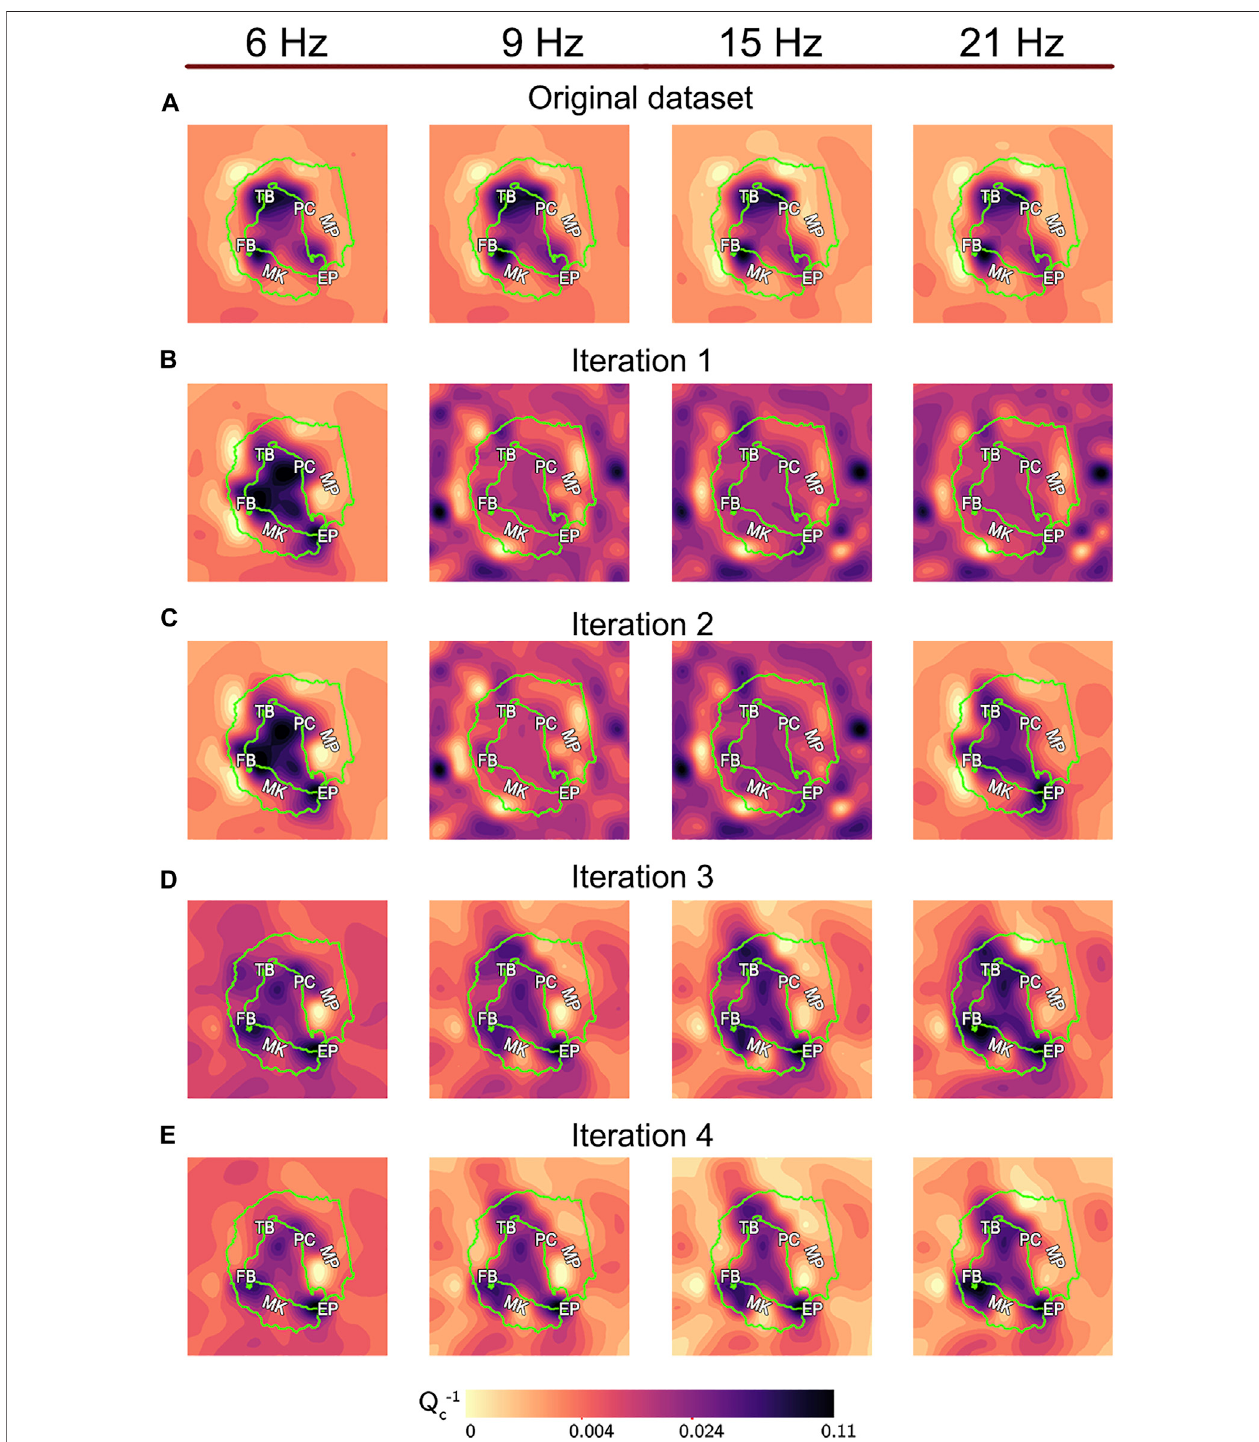
FIGURE5| Asfor Figure4 foranodespacingof1 km.Eachpanelcorrespondstoadifferentiteration.TB:TelephoneBay;PC:PendulumCove;MP:MountPond; EP: Entrance Point; MK: Mount Kirkwood; FB: Fumarole Bay.